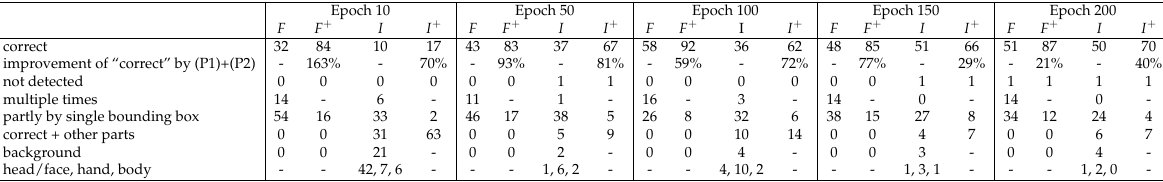
Figure A1. Results on the fruits dataset and the iCubWorld dataset using Faster R-CNN. For both datasets, the Faster R-CNN architecture was trained for 200 epochs. Panel ( a ): The metrics (mAP@0.5, recall, and precision) of the validation datasets are calculated after each 10th epoch (orange: fruits and blue: iCubWorld). For both datasets, the metrics reach high values after only a few epochs. The loss of the training dataset is shown after each epoch. Panel ( b ): Inference results on the test datasets of 100 (fruits) and 82 (iCubWorld) images, respectively, both containing more object classes than the training data. For more details about the different categories see the